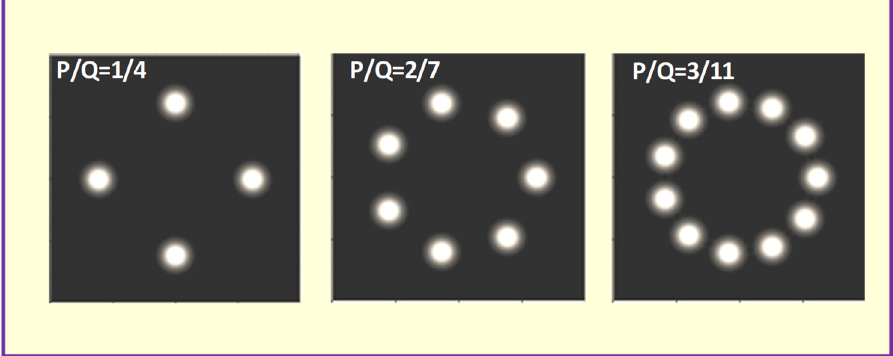
Figure 7. Calculated results by using Equation (19) with N x = N y = 50 for the transverse patterns